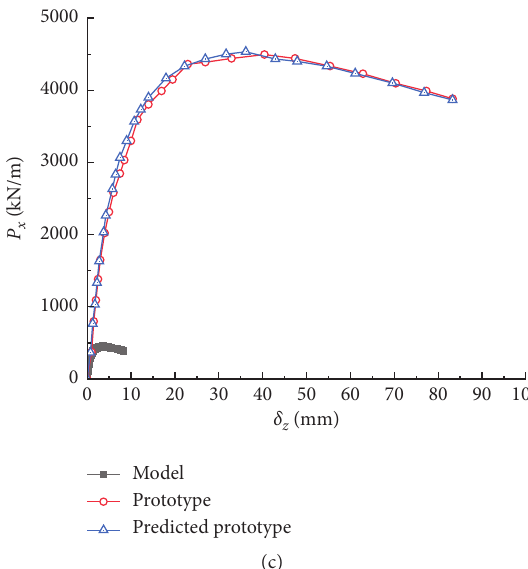
Figure 4: Comparison of complete similitude load-displacement curves for nonlinear buckling of the stiffened cylindrical shell under axial compression when λ p � 0.72 m and λ m � 0.072m. (a) δ 0 � 0.1 t . (b) δ 0 � 0.3 t . (c) δ 0 � 0.5 t